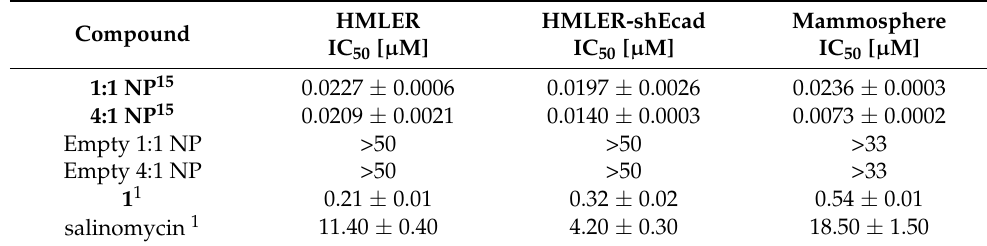
Table 1. IC 50 values of the nanoparticle formulations 1:1 NP 15 and 4:1 NP 15 , the empty